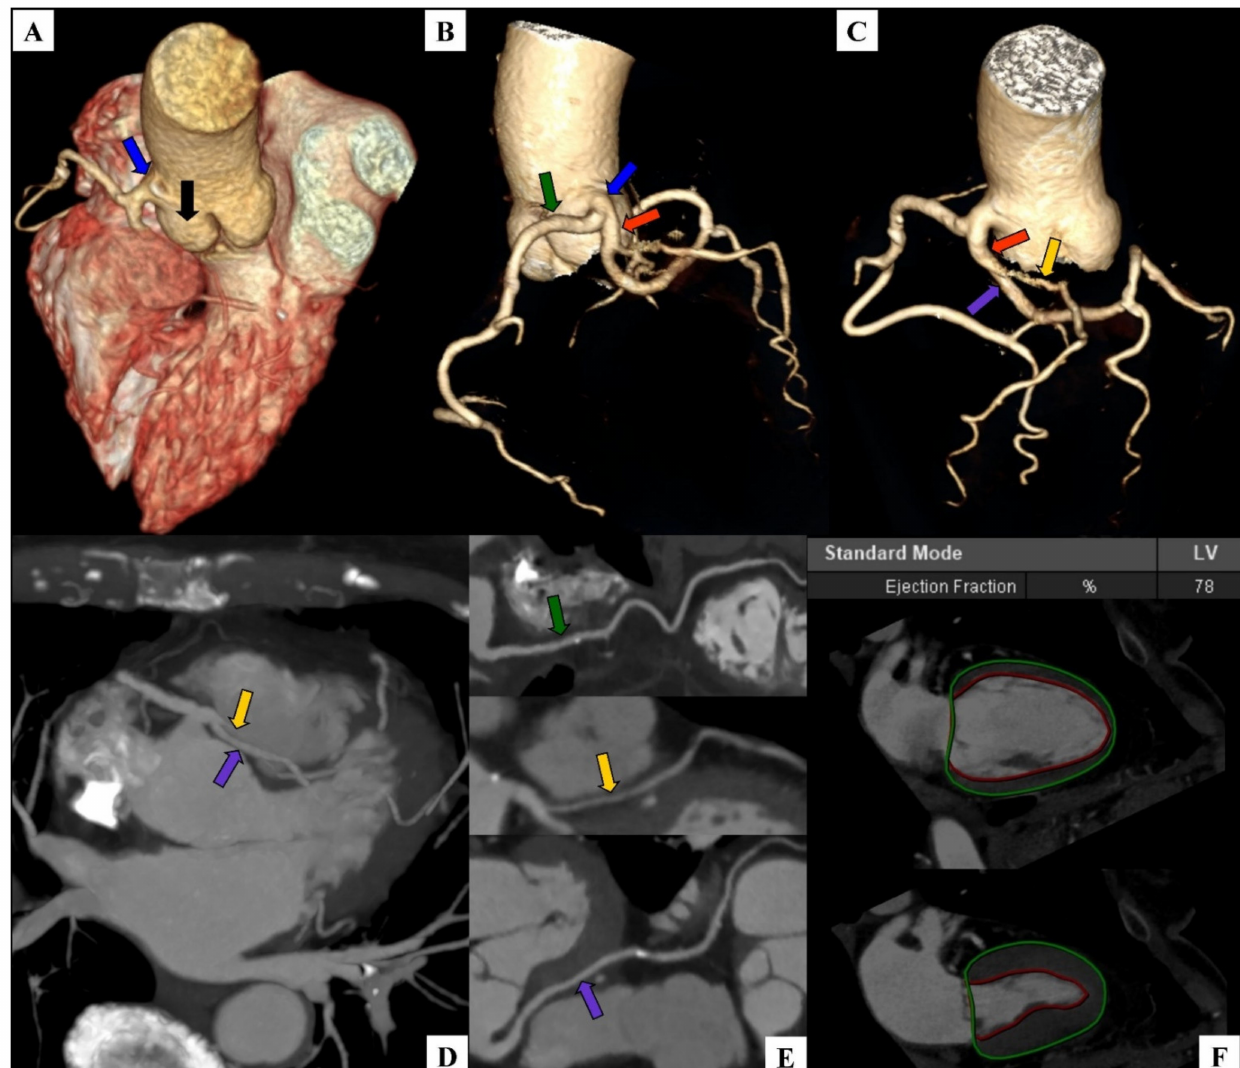
Figure 1. A single coronary artery originating from the right coronary sinus with a typical course of the right coronary artery and the interarterial course of the left main, left anterior descending, and left circumflex in coronary computed tomography angiography. On all panels, the arrows indicate: black—right coronary sinus, blue—single coronary artery, green—typical right coronary artery (RCA), orange—atypical left coronary artery (LCA), yellow—atypical left anterior descending artery (LAD), purple—atypical left circumflex artery (LCx). ( A ) Volume rendering technique (VRT). The origin of a single coronary artery from the right coronary sinus. ( B ) Volume rendering technique (VRT) with isolation of the vascular tree. Division of a single coronary artery into a typical RCA and an atypical LCA. ( C ) Volume rendering technique (VRT) with isolation of the vascular tree. Division of an atypical LCA into an atypical LAD and an atypical LCx. ( D ) Maximum intensity projection (MIP). Axial view. The interarterial course of LAD and LCx ( E ) curved planar reformation (CPR). Sequentially from the top: typical course of a right coronary artery, atypical course of a left anterior descending artery, atypical course of a left circumflex artery. ( F ) Left ventricular functional assessment. Left ventricular ejection fraction